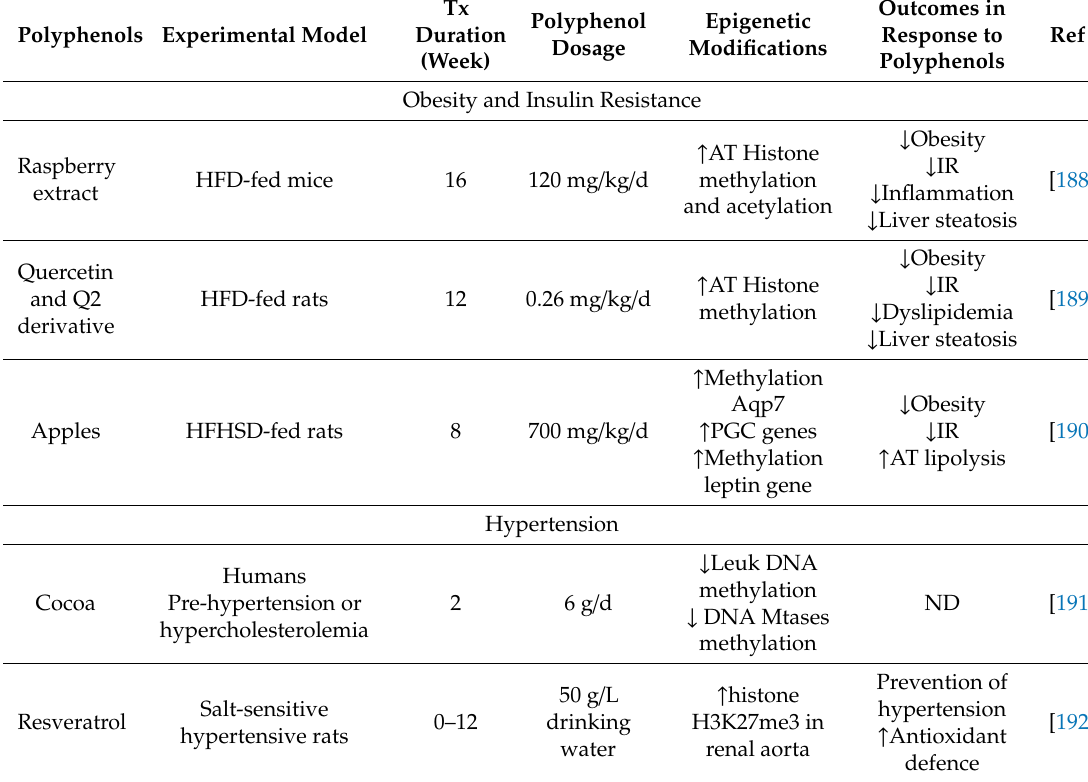
Table 3. E ff ect of polyphenols on DNA and histone methylation and acetylation. Polyphenols Experimental